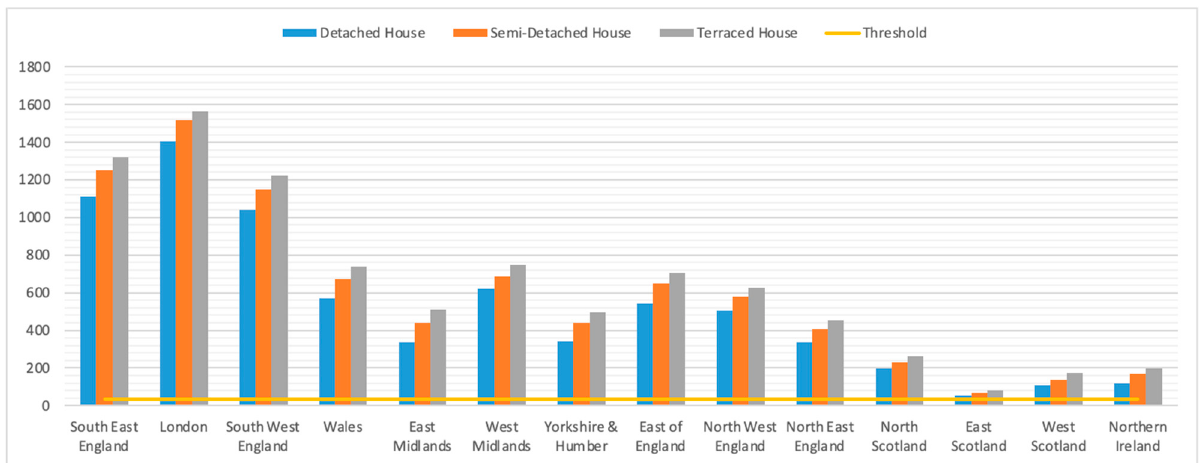
Figure 8. Base model annual bedroom overheating with PROMETHEUS 2050s, high-emissions climate data; line shows 32 h overheating threshold.